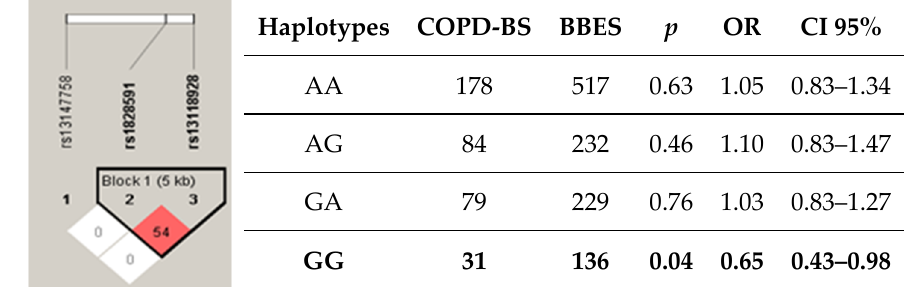
Figure 1. Haplotypes of rs1828591 and rs13118928 in the HHIP gene. COPD ‐ BS: COPD related to biomass ‐ burning exposure; BBES: Biomass ‐ burning smoke ‐ exposed subjects: p < 0.05 demonstrates significance; OR: odds ratio; CI 95%: 95% confidence interval; showing r 2 values among SNPs.